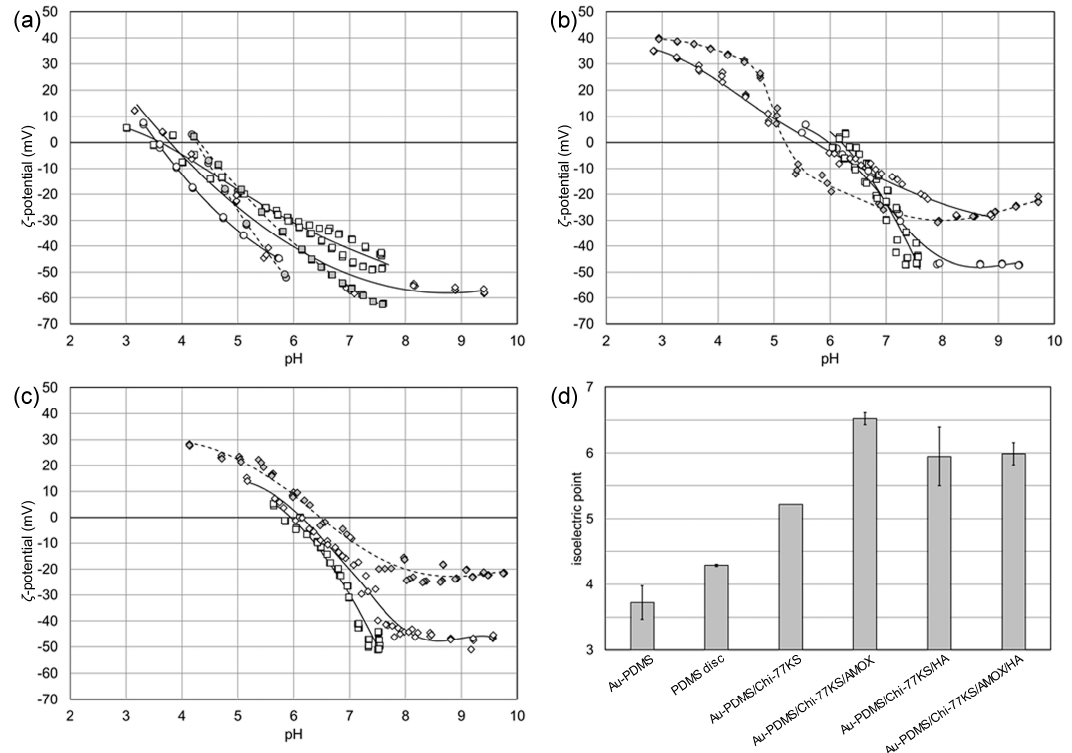
Figure 7. pH dependence of ζ -potential for ( a ) PDMS thin-film coating on gold sensors (empty symbols) and PDMS disc (filled symbols), ( b ) Au-PDMS/Chi-77KS (filled symbols) and Au-PDMS/Chi-77KS/HA (empty symbols), ( c ) Au- PDMS/Chi-77KS/AMOX (filled symbols) and Au-PDMS/Chi-77KS/AMOX/HA (empty symbols), and ( d ) isoelectric points. Square symbols represent the measurement in PBS, circles in 0.0024 mol/L KCl, and diamonds in 0.01 mol/L KCl.